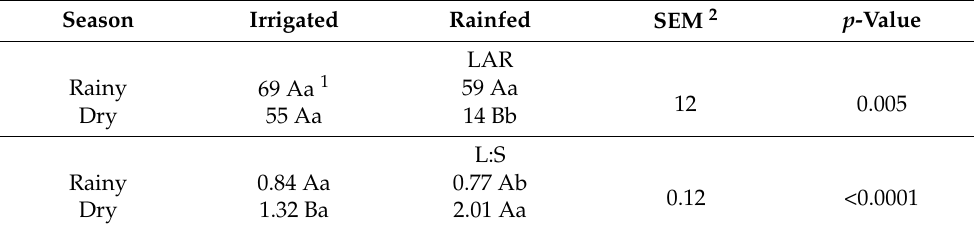
Table 3. Leaf accumulation rate (LAR; kg dry matter/ha per day) and leaf:stem (L:S) ratio, as affected by the interaction between irrigation and season for elephantgrass genotypes at Garanhuns, Pernambuco, Brazil.